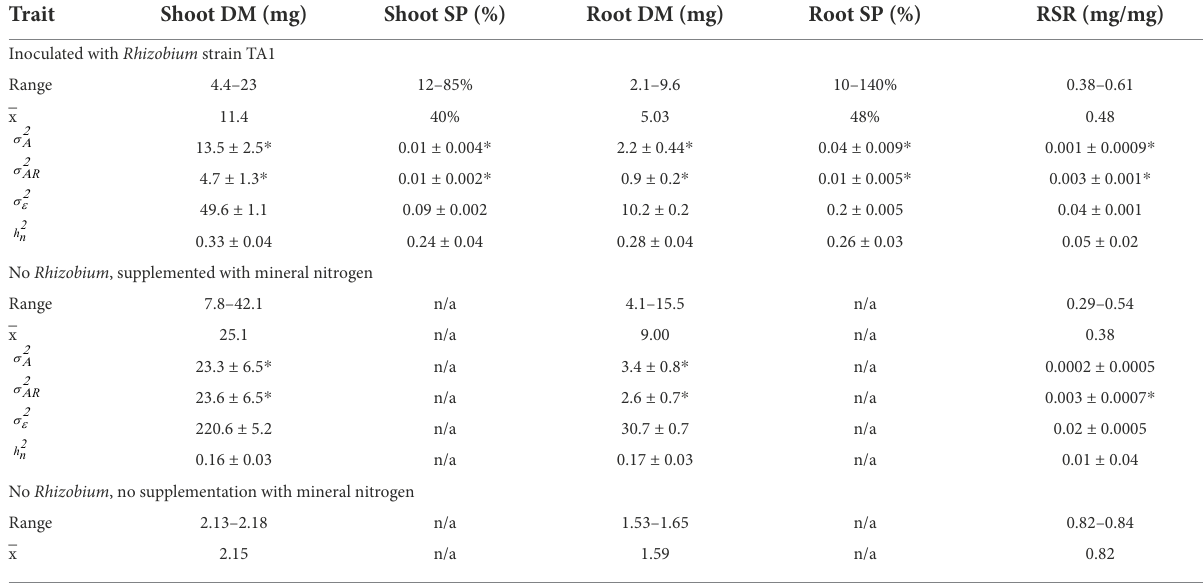
TABLE 1 Trait Best Linear Unbiased Predictor (BLUP) values, variance components and narrow-sense heritabilities for 120 white clover half-sib families either inoculated with Rhizobium leguminosarum bv. trifolii strain TA1 or grown with mineral nitrogen and no Rhizobium , or a balanced bulk of 120 half-sib families grown with no Rhizobium nor mineral